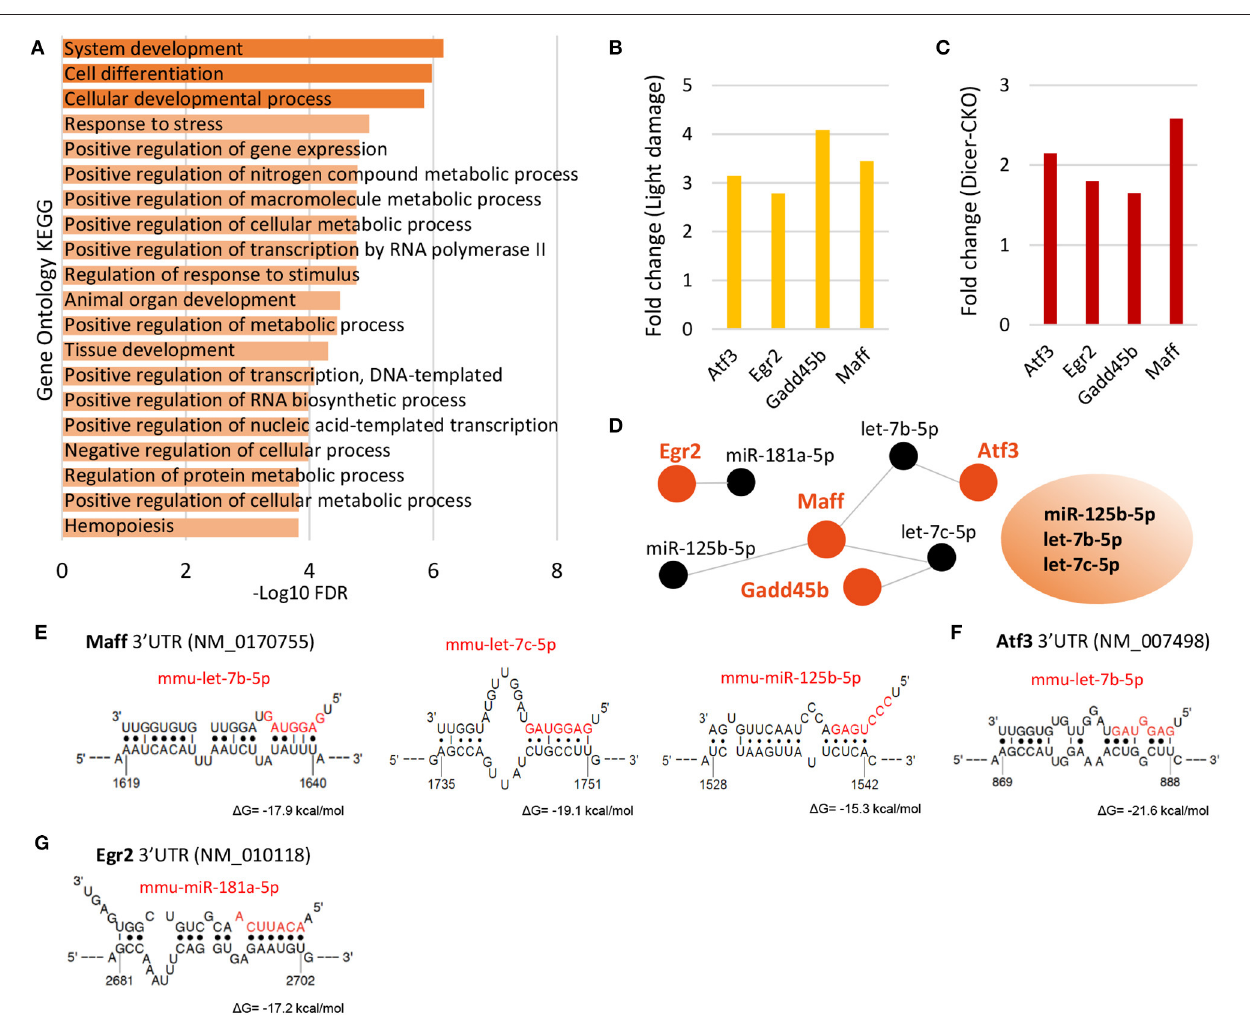
FIGURE 6 | Upregulated genes after light damage and after Dicer deletion and their potential miRNA regulators. (A) Gene ontology of the top 20 genes upregulated the most after Dicer deletion and light damage (LD), FDR: false discovery rate. (B,C) Top four genes upregulated after light damage ( B , fold change of log 2 relative expression of light damage vs. controls, five and six biological replicates, respectively, one technical replicate per condition) or Dicer deletion ( C , fold change of log 2 counts per million of wild type or Dicer-deleted MG, 20 and 14 biological replicates, respectively, 1 technical replicate per condition). (D) DIANA-TarBase predicted miRNAs regulating the top four genes ( Atf3 , Egr2 , Gadd45b , and Maff ) upregulated in the Dicer-cKO and after light damage and miRNAs found to be regulating the top genes after LD and the top 4 genes in the light damage/Dicer-cKO dataset i.e., miR-125b-5p, let-7c-5p, and let-7b-5p. (E–H) Binding sites of identified miRNAs from D (DIANA-TarBase) in the 3 ′ UTRs of Maff (E) , Atf3 (F) , and Egr2 (G) using STarMirDB. The seed sequences of the particular miRNA are shown in red. Dots represent complimentary base pairing. 1 G indicates the structural accessibility at the target site.